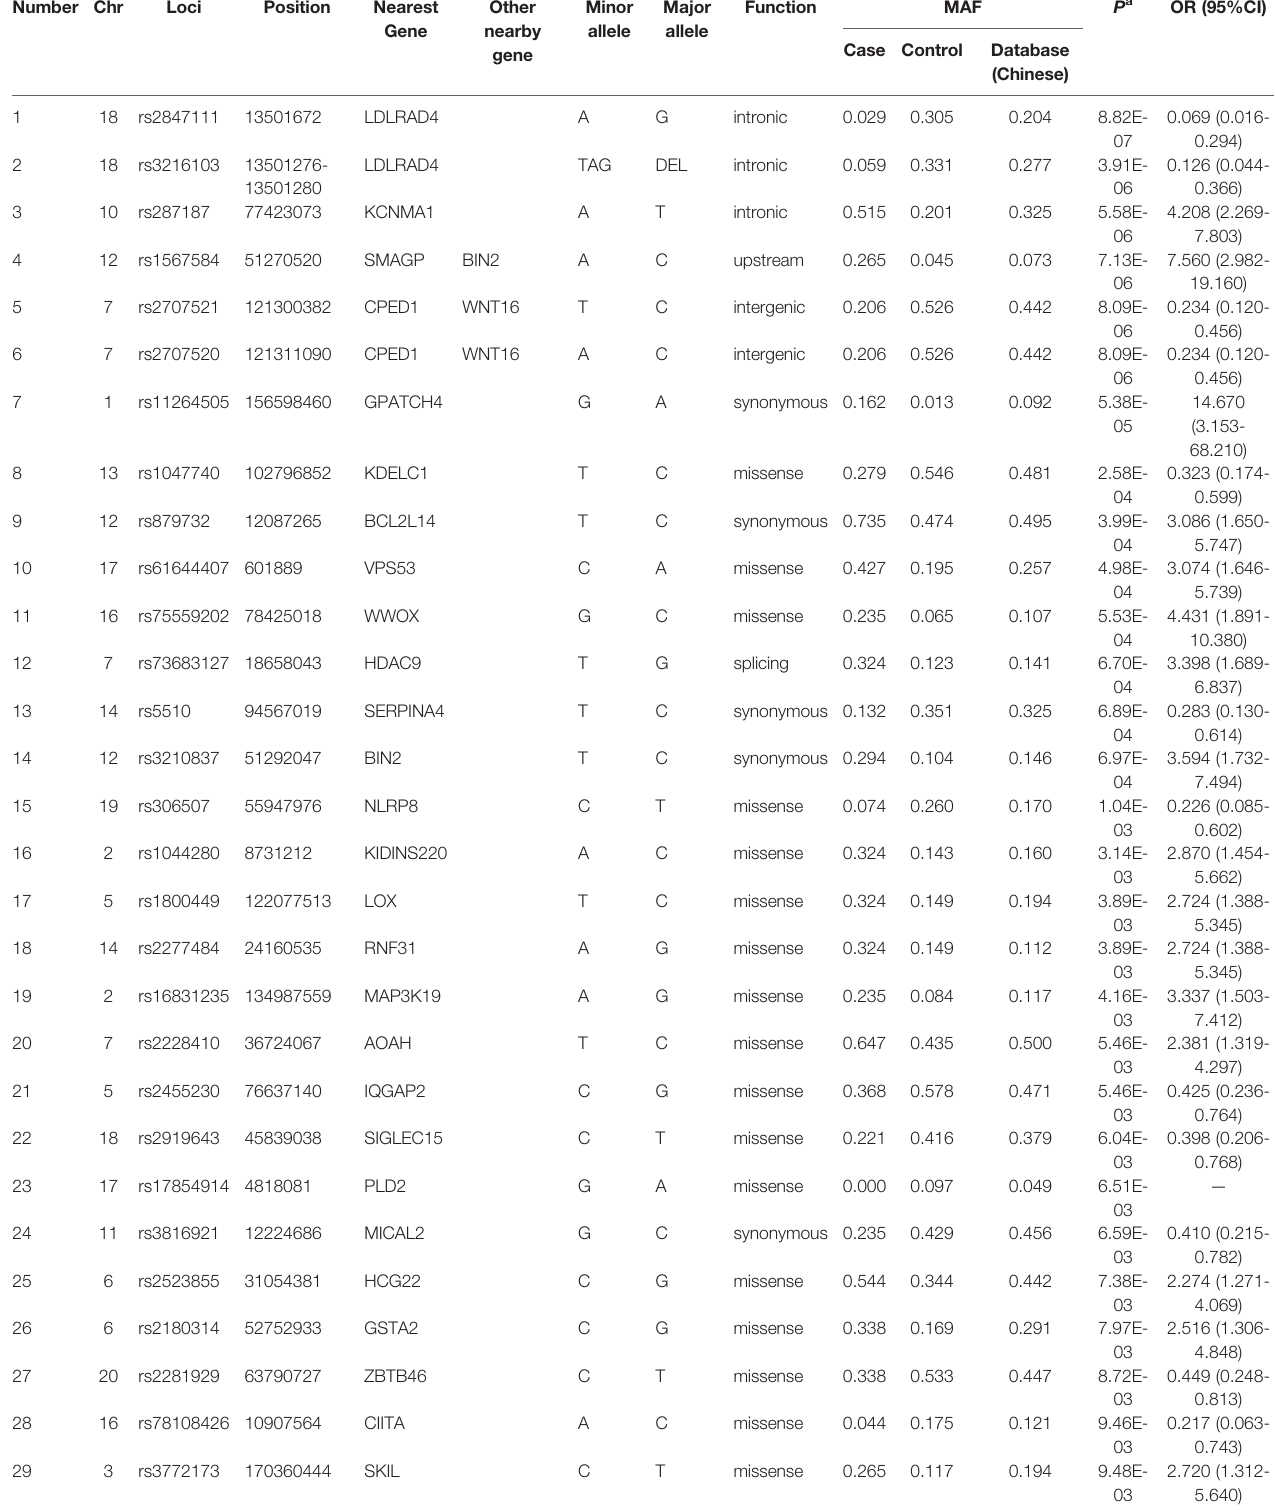
TABLE 2 | Loci of interest from genome-wide association